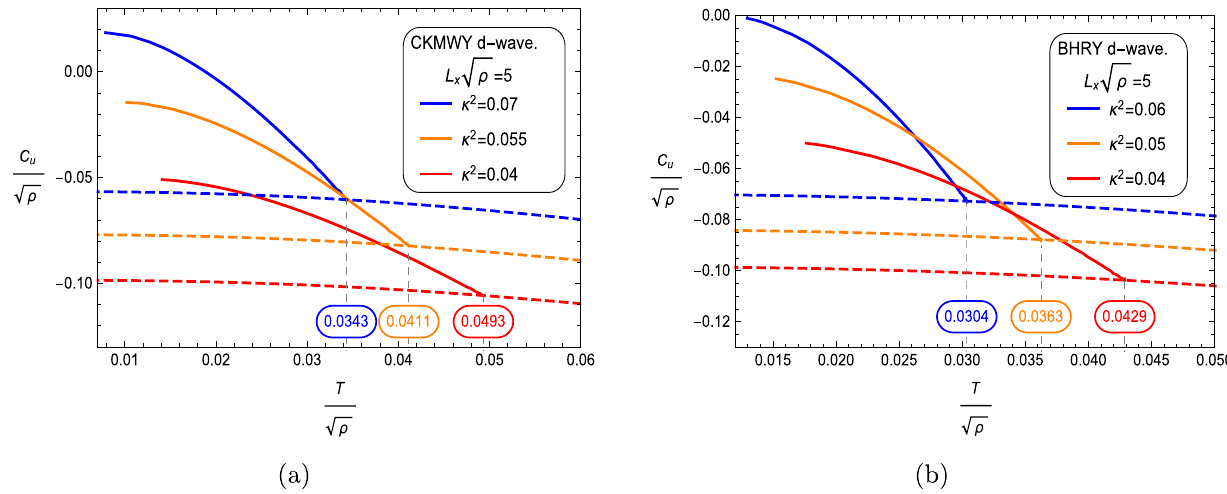
√ ρ for the CKMWY ( a ) and the BHRY ( b ) d-wave superconductor with a fixed subregion